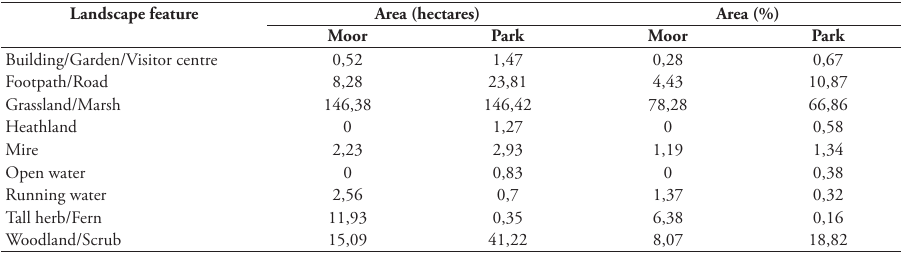
table 2. Landscape features in Lyme Park and their relative percentage covered and area, separated for the Park and Moore deer herd.